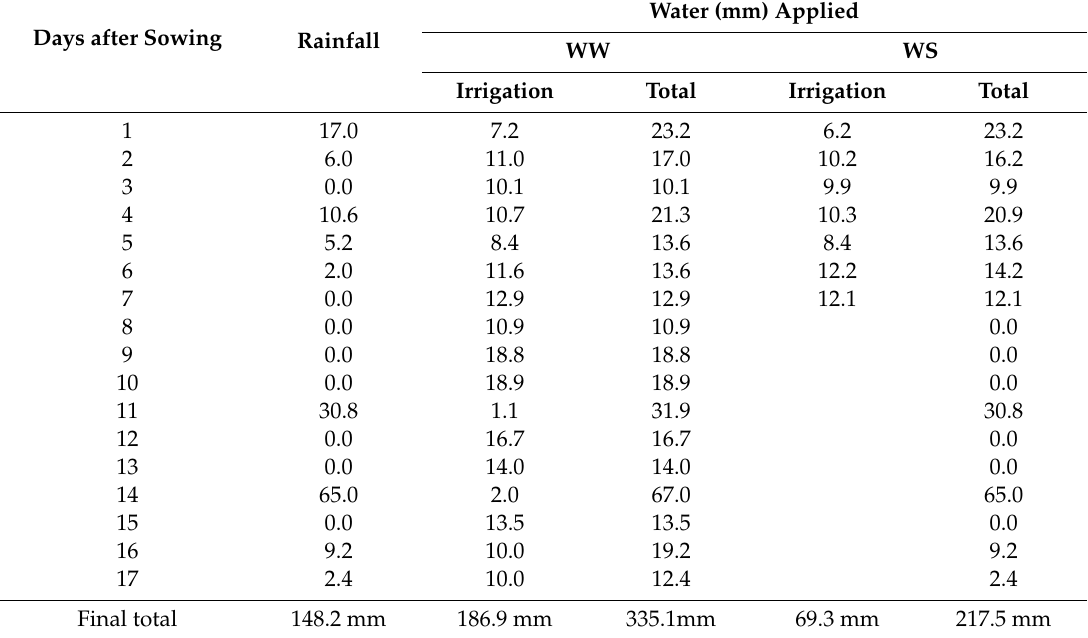
Table 1. Precipitation and irrigation levels (mm) applied to popcorn under well-watered (WW) and water-stressed (WS) conditions in the weeks after sowing. Days after Sowing Rainfall